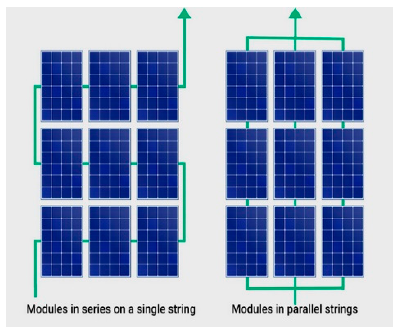
Figure 3. String Configuration.